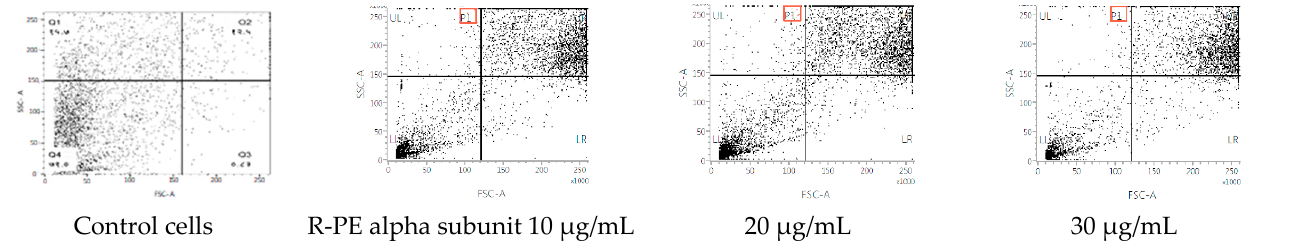
Figure 7. Flow cytometric analyses of R-phycoerythrin alpha subunit-treated cells.